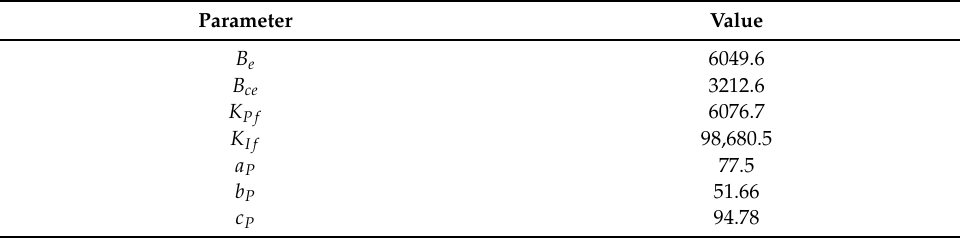
Table 4. Gain and output level function coefficient values obtained by optimization.